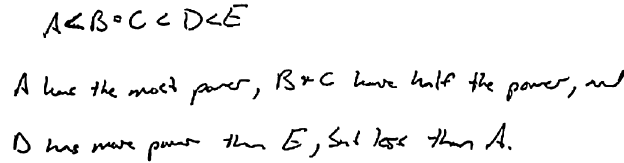
‘‘nearly correct’’ for PCK.